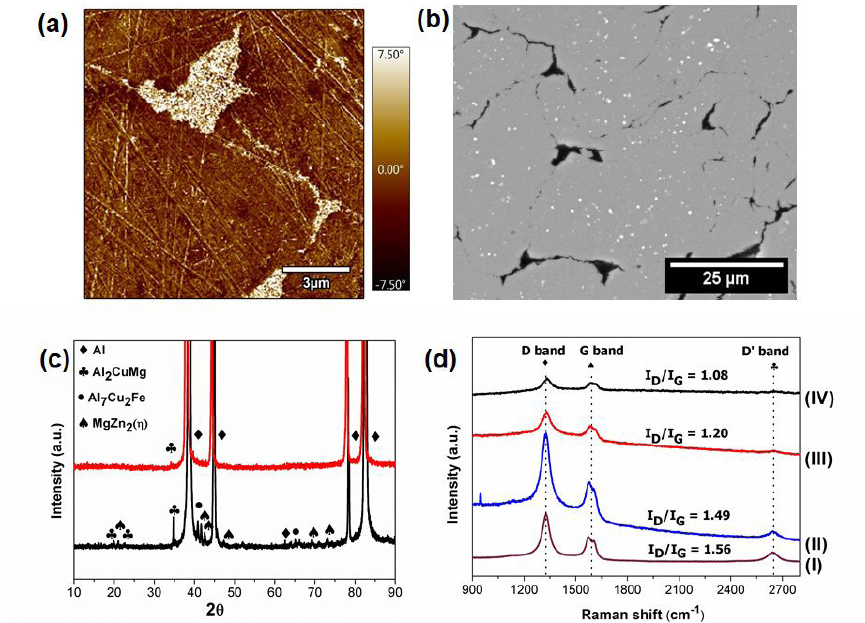
Figure 3. (a) Composite A phase images obtained by AFM; (b) SEM image of artificial aged sample; (c) XRD patterns of the hot extruded composite (I), (II) after artificial aging; and (d) Raman spectra of (I) composite powder, (II) hot extruded composite, (III) solubilized , and (IV) artificial aged